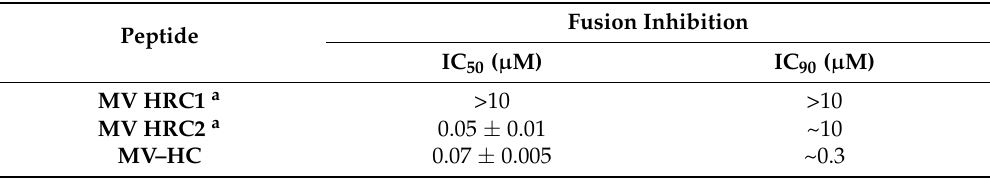
Table 2. Fusion inhibition activity, at 24 h, of MV HRC derived